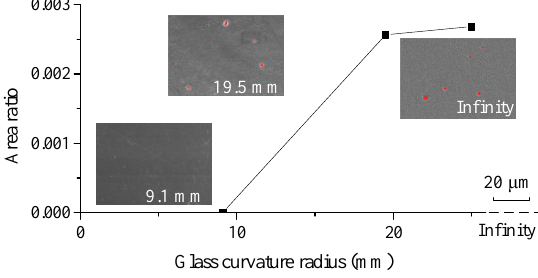
Figure 20. Area ratios of the microdimples of the formed ChG pillars with different glass surface curvature radii under 4085 N at a molding temperature of 382 °C.